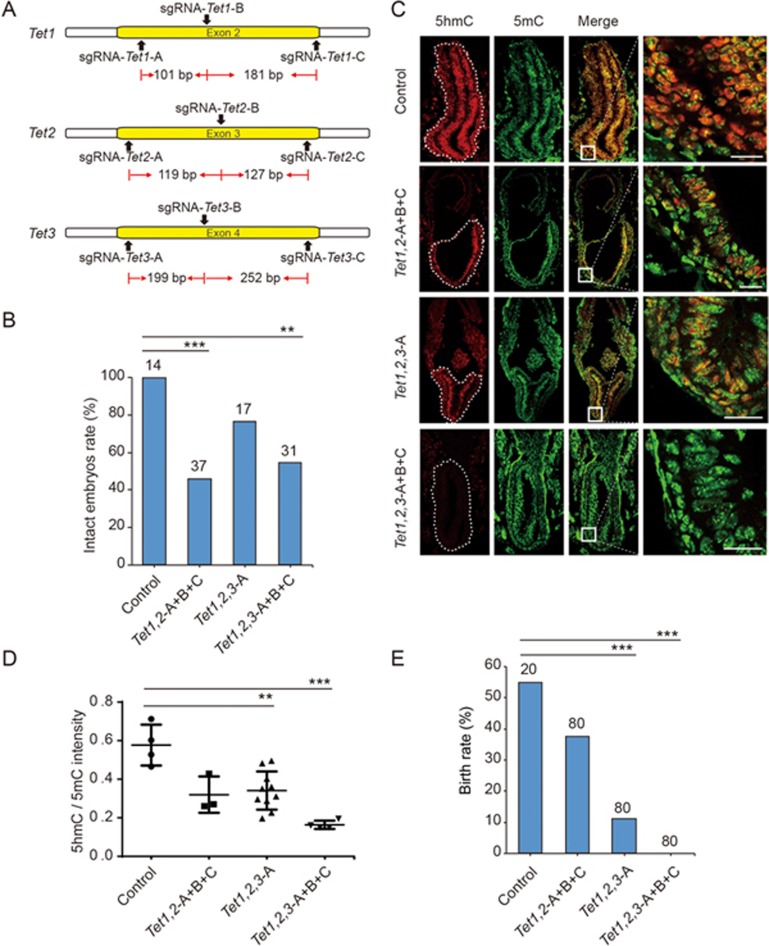
One-step generation of mice with complete triple knockout of Tet genes by C-CRISPR. (A) Schematic diagram of sgRNA-targeting sites at Tet1, Tet2 and Tet3 loci, with three sgRNAs for each locus. (B) Percentages of control and Tet gene-edited E7.5 embryos that were intact. Number, total number of embryos counted (***P < 0.001, **P < 0.01, χ2 test). (C) Immunostaining of tissue sections showing the level of 5hmC (red) and 5mC (green) in E7.5 embryos with different forms of Tet gene targeting. White-dashed line, epiblast of E7.5 embryos, with boxed regions shown at a higher resolution on the right. “5hmC”, 5-hydroxymethylcytosine; “5mC”, 5-methylcytosine; scale bar, 50 μm. (D) The relative levels of 5mC and 5hmC in E7.5 embryos. Each data point represents the ratio (5hmC/5mC) of the average immunofluorescence intensities measured from one tissue section. Error bars, SEM (***P < 0.001, **P < 0.01, unpaired t-test). (E) Birth rate of mice for control embryos and different forms of Tet gene targeting. Number: total number of embryos transferred to surrogates (***P < 0.001, χ2 test).